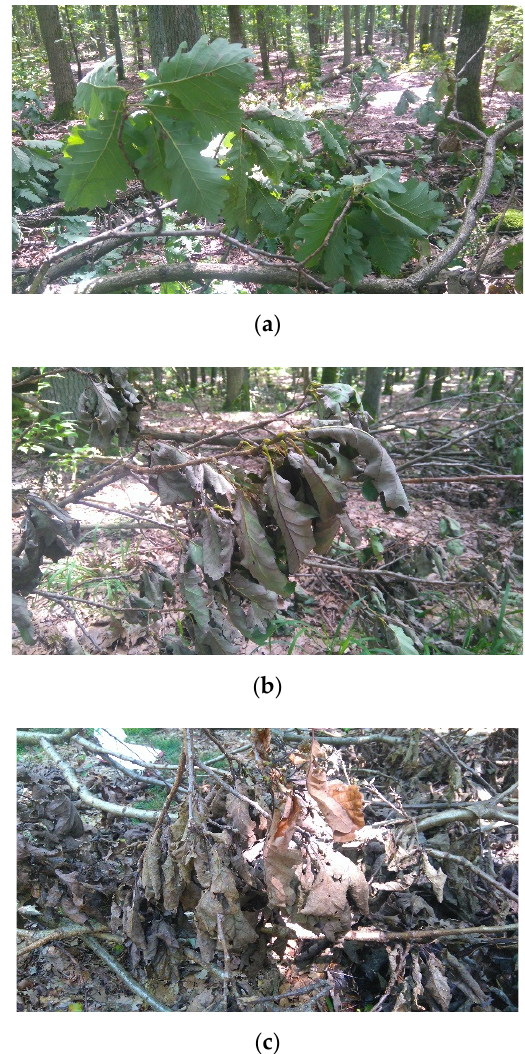
Figure 2. Changes in the condition of the leaves over the time for reducing water: ( a ) 2 weeks after tree felling; ( b ) 4 weeks after tree felling; ( c ) 6 weeks after tree felling. Each sample of 30 leaves was weighed in green condition immediately after